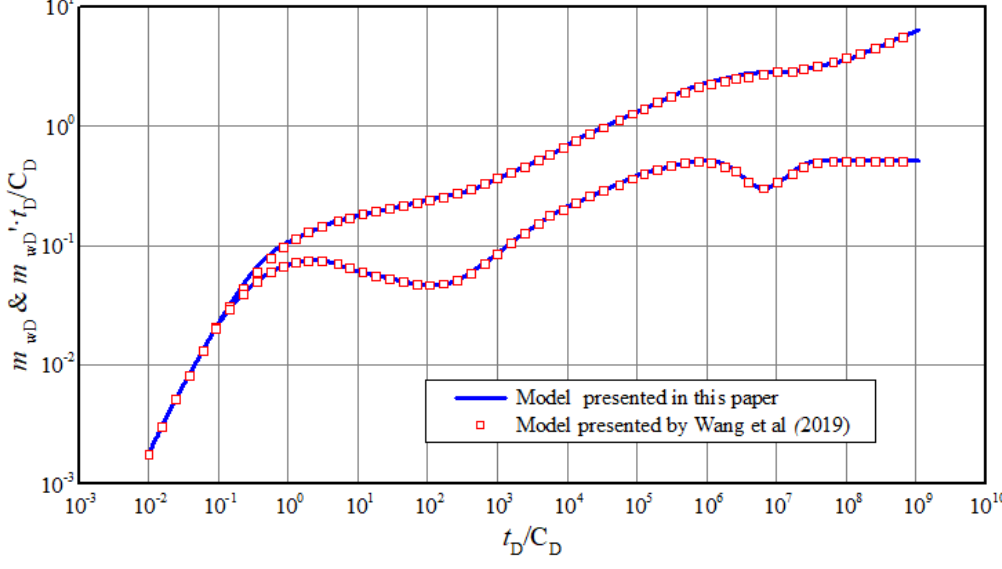
Figure 2. Comparison of transient pressure curves with results of Wang et al.’s model.